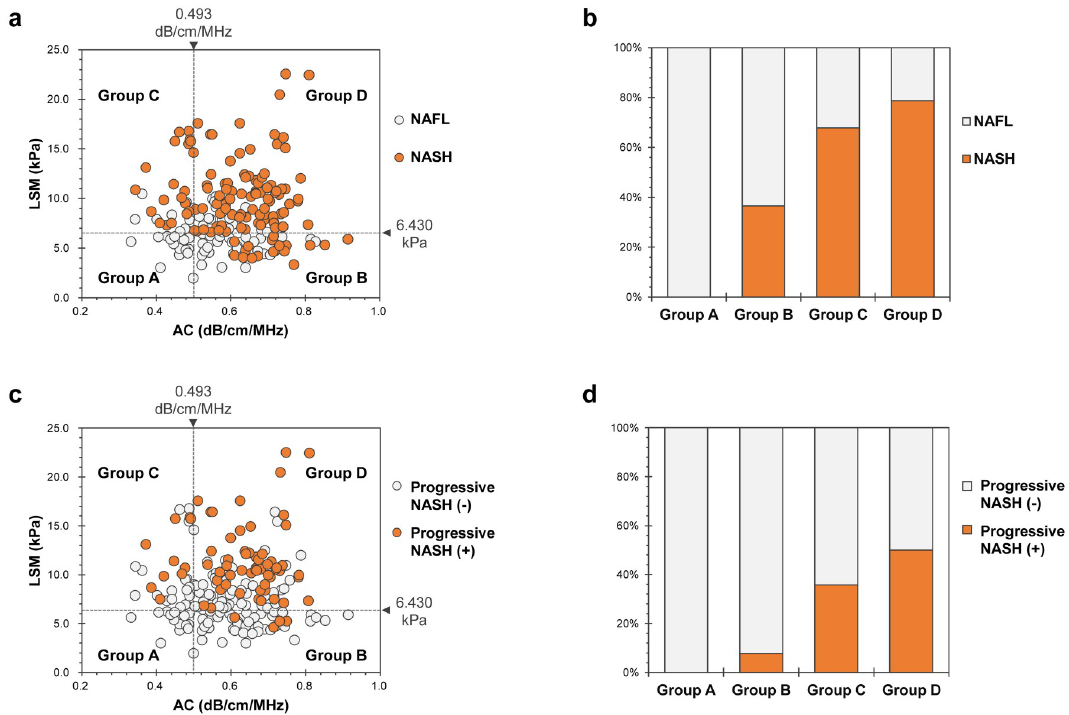
Fig 3. NASH or progressive NASH patient distribution according to LSM and AC. a, c: All patients with nonalcoholic fatty liver disease were divided into four groups, according to the cutoff values of LSM and AC for fibrosis stage � F1 and steatosis grade � S1 [NASH (a), progressive NASH (c)]. b, d: Percentage of NASH (b) or progressive NASH (d) patients in each group. Percentages of NASH patients in Groups A, B, C, and D were 0.0% (0/14), 36.5% (19/52), 67.97% (19/28), and 78.7% (85/108), respectively; there was a significant difference in the distribution among groups (P < 0.001) (b). Percentages of progressive NASH patients in Groups A, B, C, and D were 0.0% (0/14), 7.7% (4/52), 35.7% (10/28), and 50.0% (54/108), respectively; there was a significant difference in the distribution among groups (P < 0.001) (d). LSM, liver stiffness measurement; AC, attenuation coefficient.